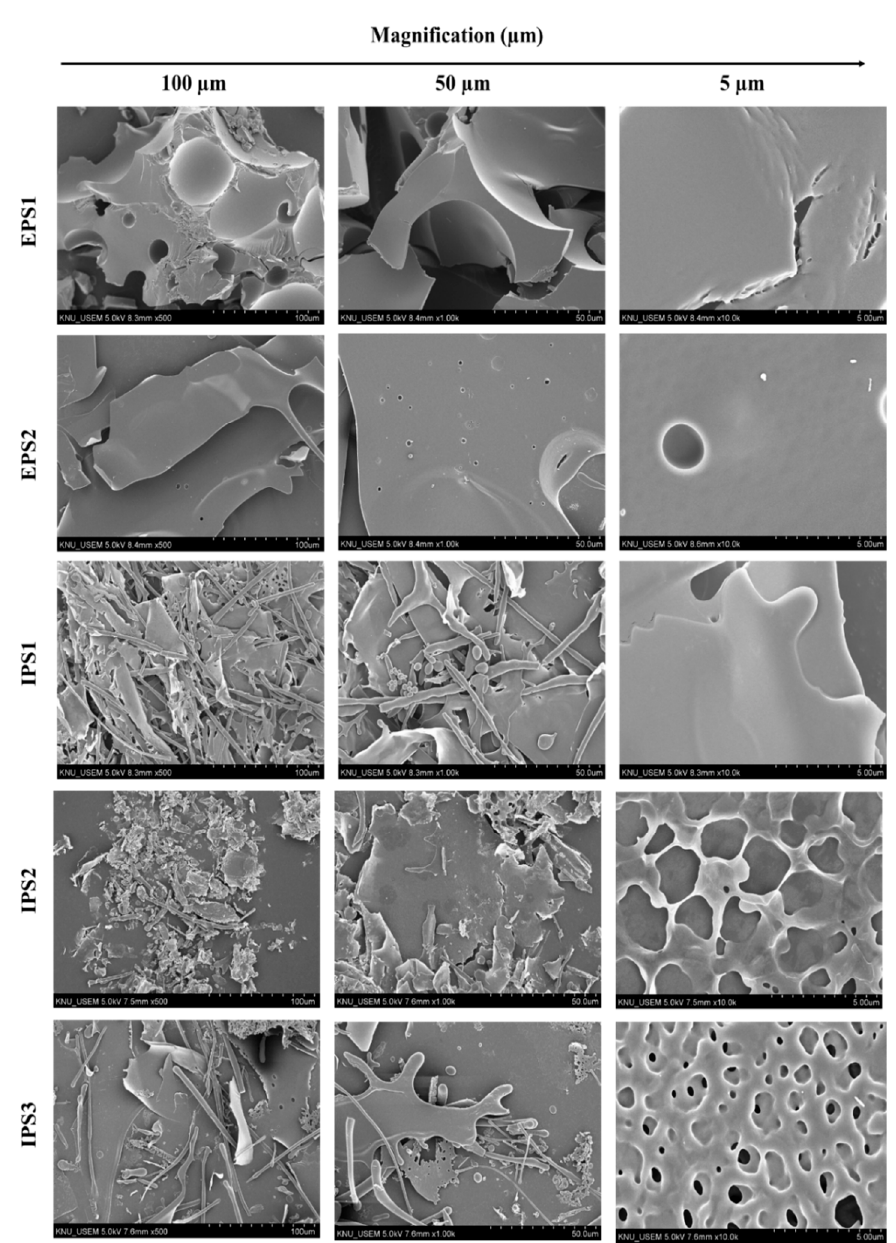
Figure 4. Scanning electron microscopic observation of the surface morphology of EPSs (1 and 2) and IPSs (1–3) at different magnifications (100 µm, 50 µm, and 5 µm). IPSs (1–3) at different magnifications (100 µ m, 50 µ m, and 5 µ